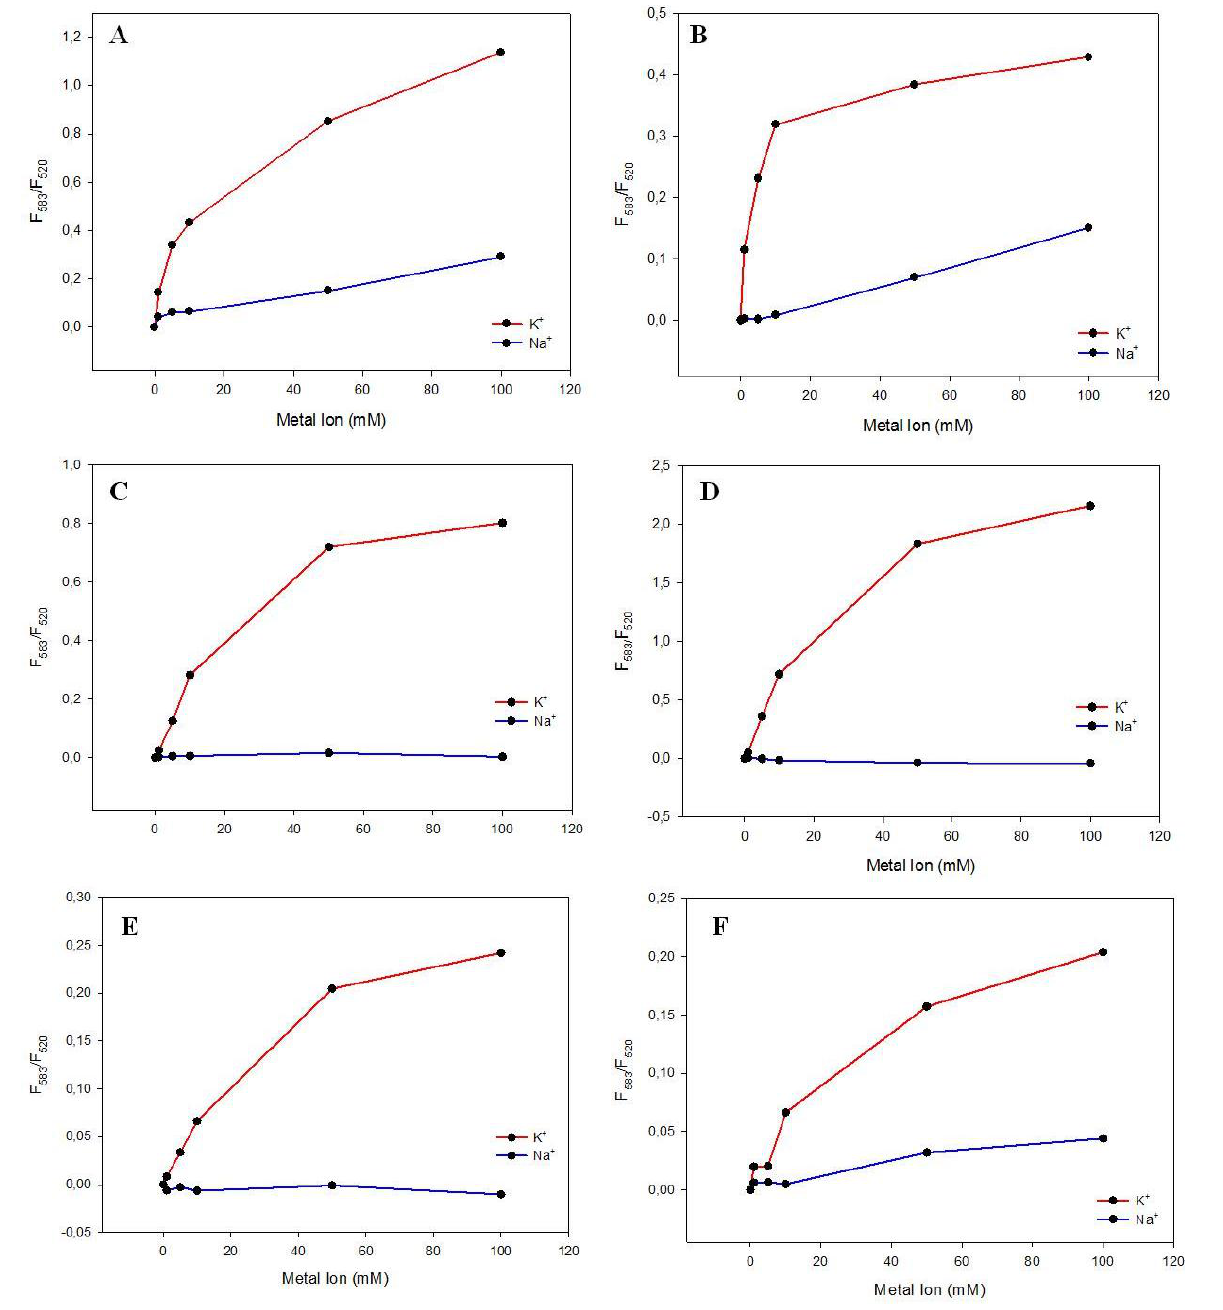
Figure 8. Effect of K + and Na + ions on FRET efficiency, expressed as F 583 /F 520 ratio, for ( A ) F19T, ( B ) ChF19T, ( C ) 16F19T, and ( D ) Ch16F19T probes; and ( E ) 16F19T/Ch16’ and ( F ) Ch16F19T/Ch16’